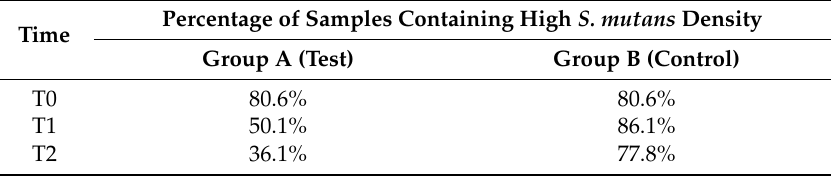
Table 1. Percentage of samples containing a high density of Streptococcus mutans CFU ( ě 10 5 CFU/mL). Percentage of Samples Containing High S. mutans Time